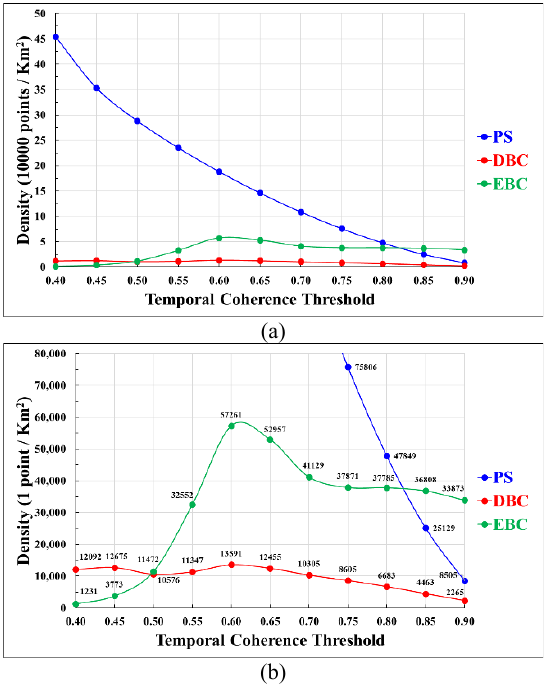
Figure 7. Point density versus temporal coherence threshold. (a) and (b), small and large scales.